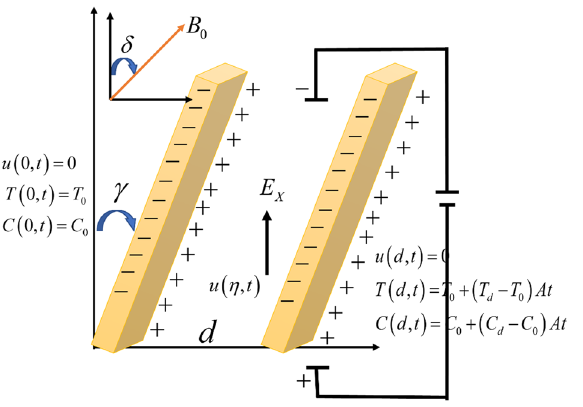
Figure 1. Geometry of the